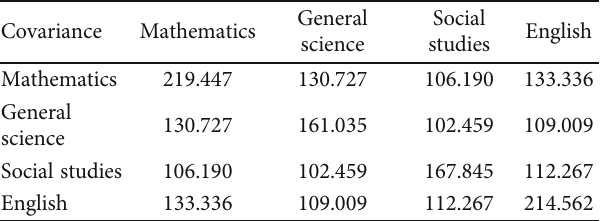
Table 2: The covariance for total tribal students. Covariance